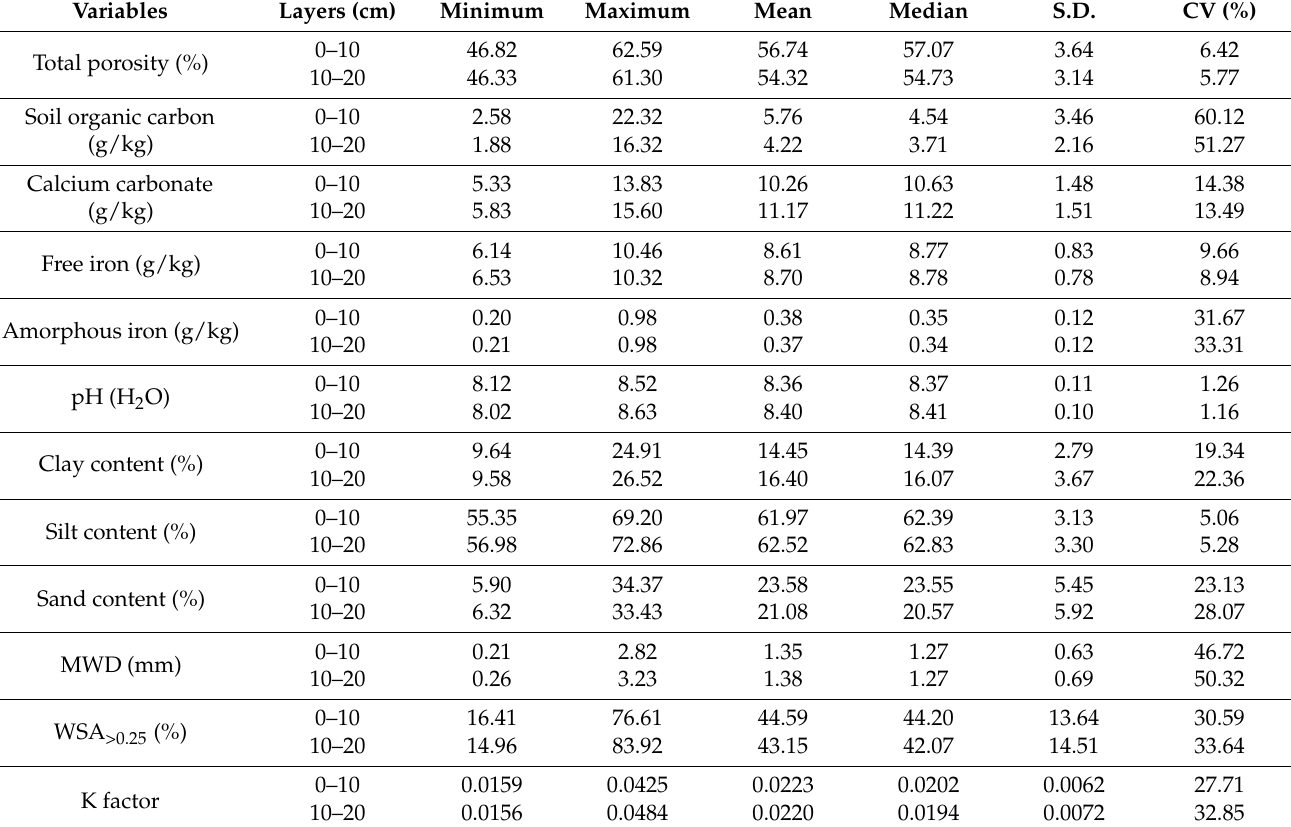
Table 1. Summary statistics for the aggregate stability, K factors, and selected